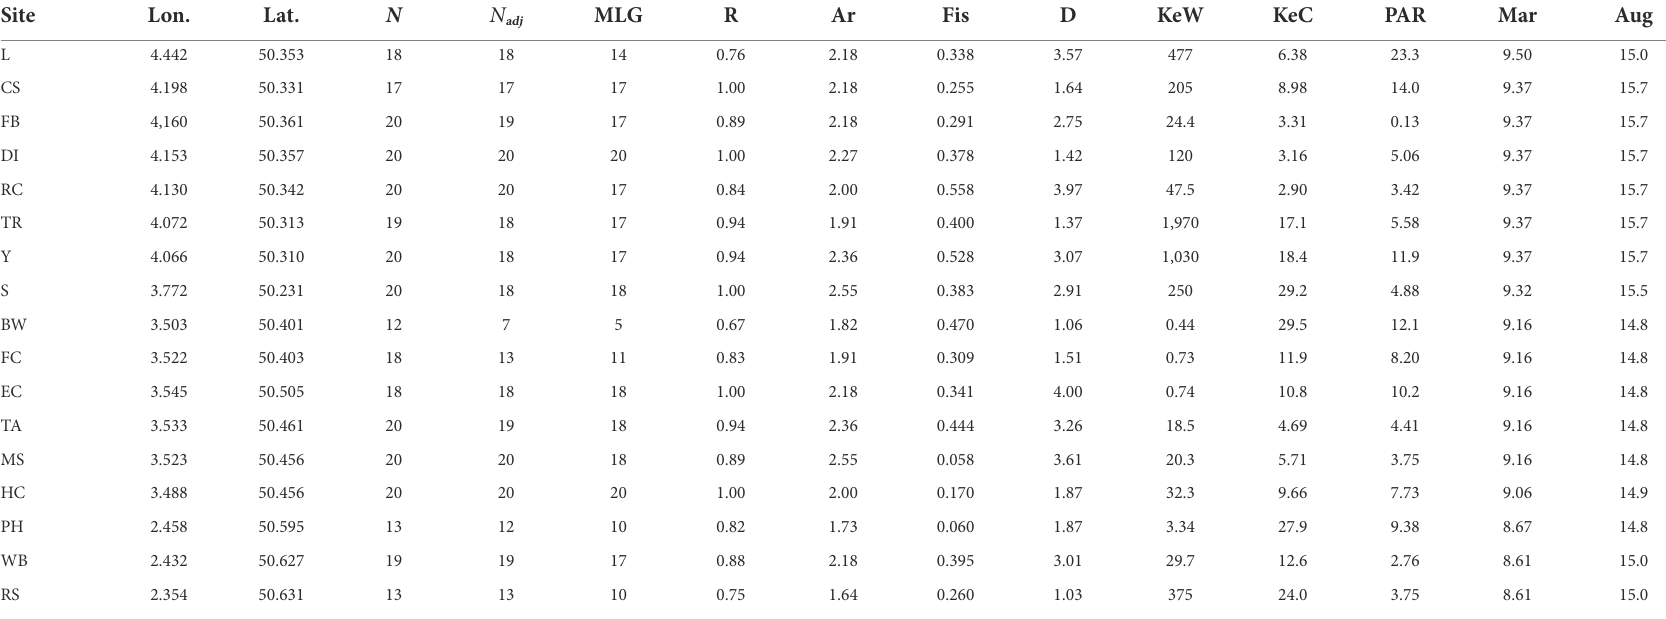
TABLE 1 Zostera marina population genetic parameters and associated environmental parameters from 17 sampling locations across the south of England. Site Lon.